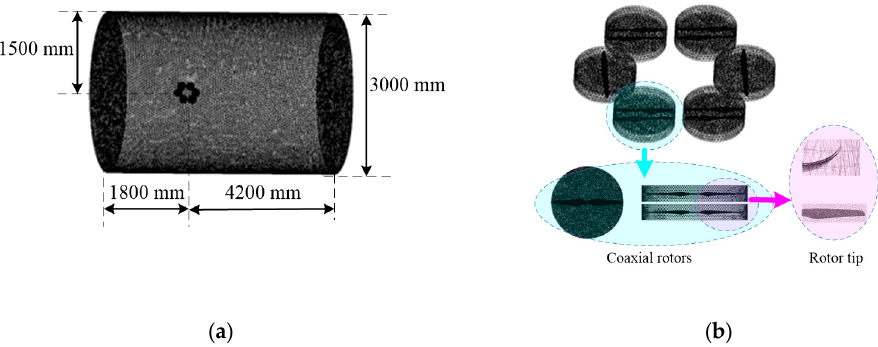
Figure 8. Mesh distribution: ( a ) Computational domain; ( b ) mesh details.